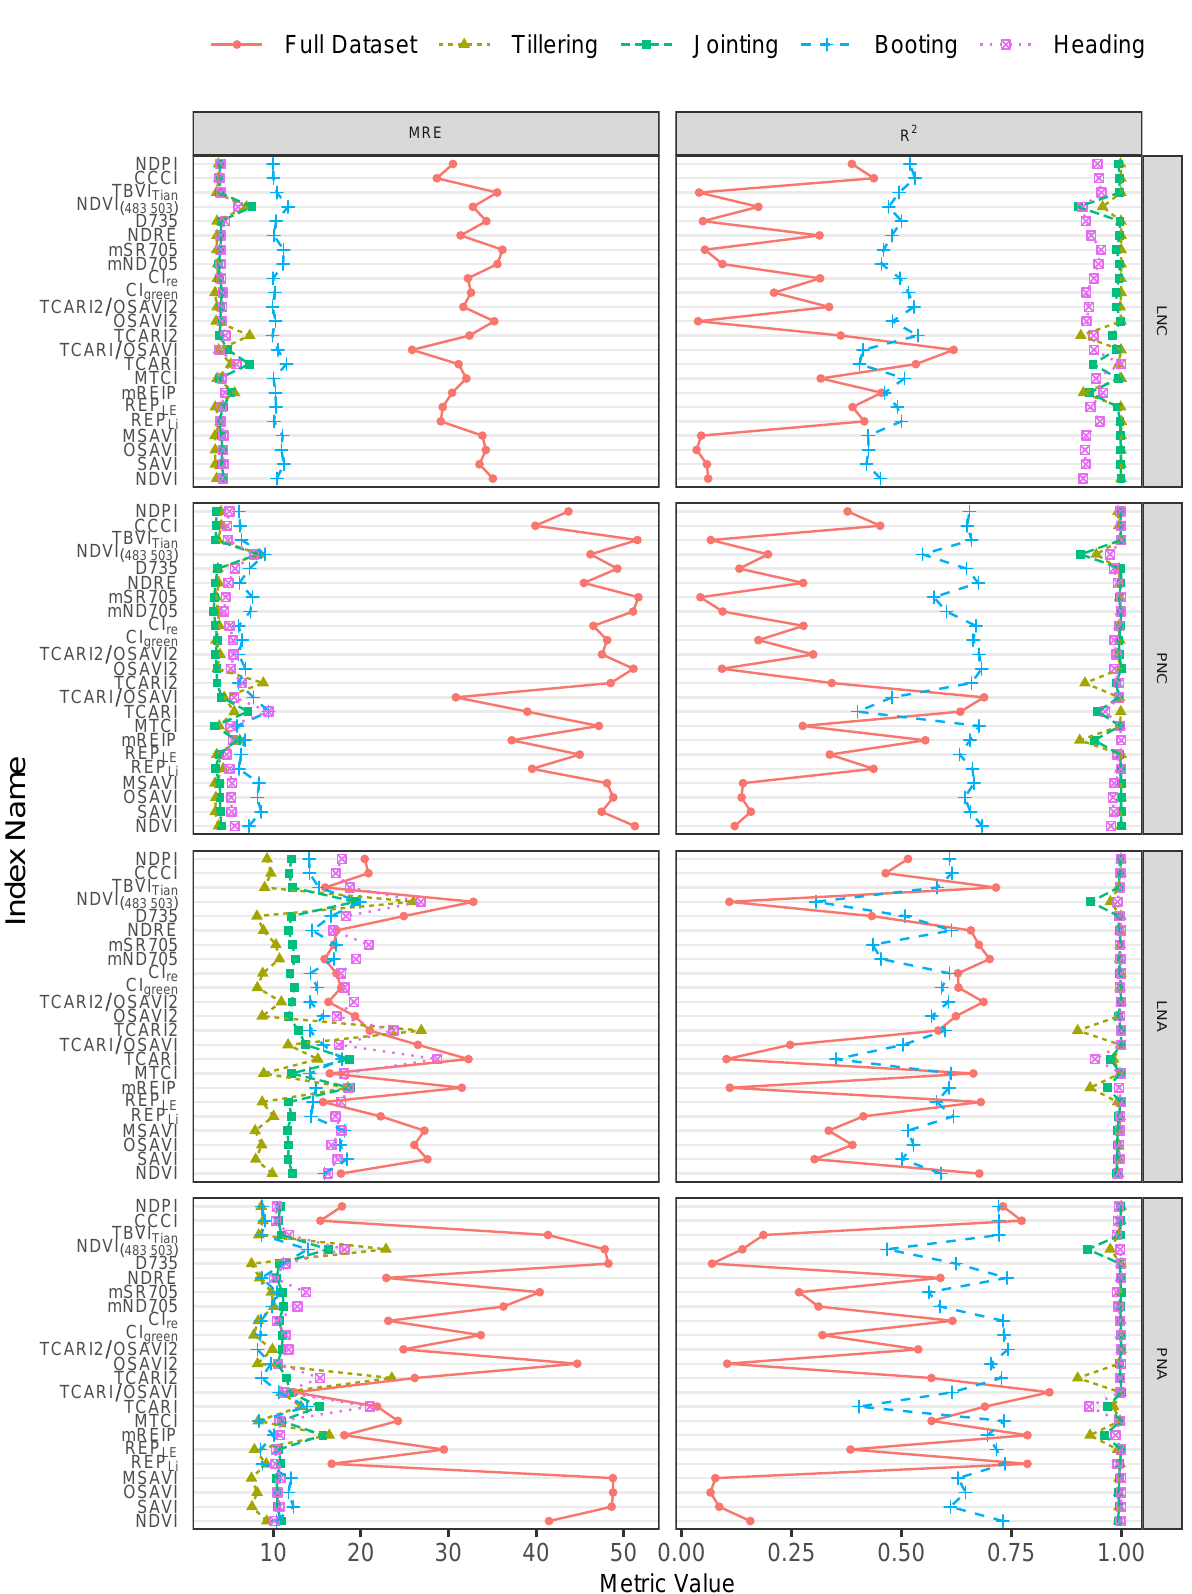
Figure 4. Growth-stage-specific and full-growth-stage cross-validated MRE and R 2 values of selected VIs for LNC, PNC, LNA and PNA